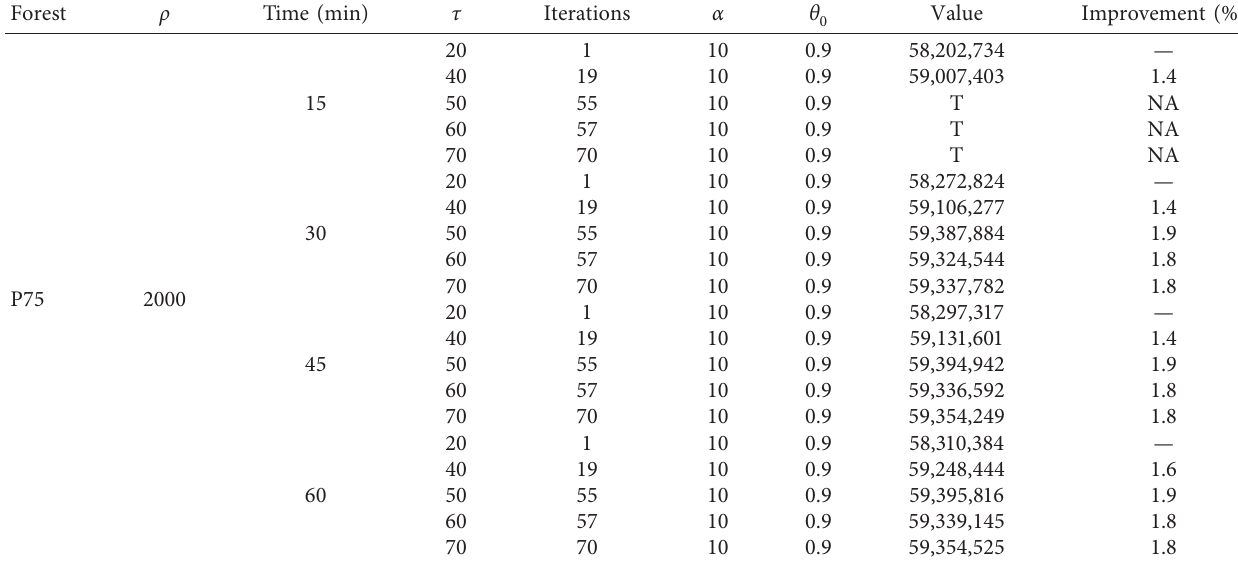
Table 7: Effects of τ and allocated time for the forest